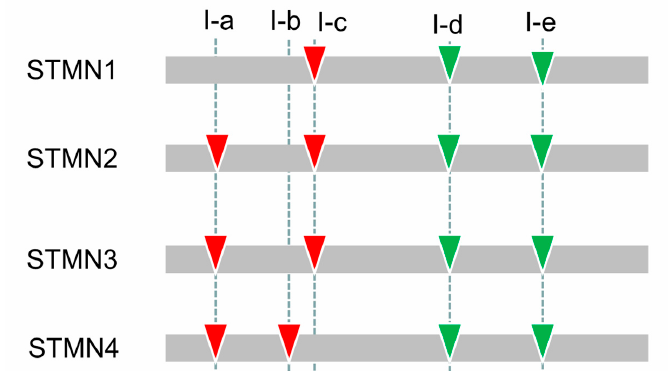
Figure 2. Exon–Intron organization of the stathmin genes in different groups. The inverted triangles with green and red marks indicate the insertion positions of phase 0 and 1 introns, respectively. Five conserved introns (I-a, I-b, I-c, I-d, and I-e) were also named and marked.